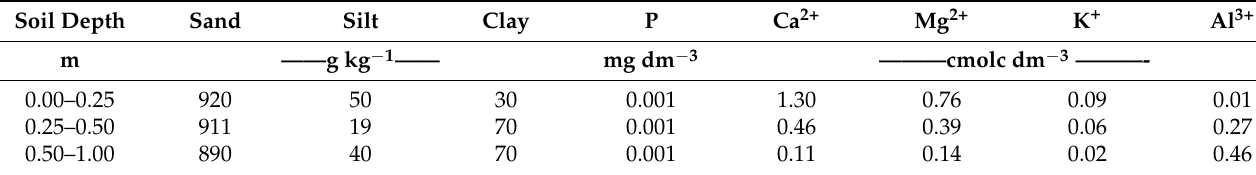
Table 1. Granulometric and chemical characterization of experimental area located in the municipality of Itirapina in the state of São Paulo, Brazil.